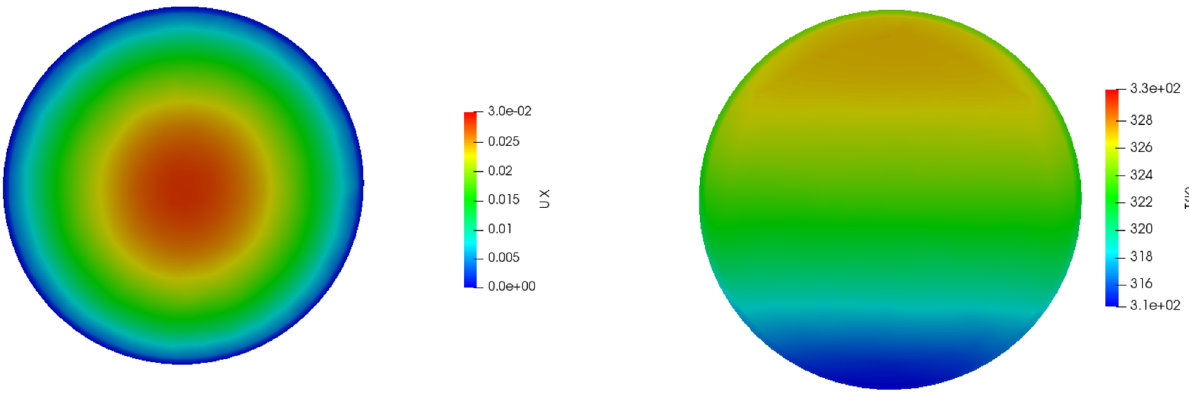
Fig. 13. Velocity (sx) and temperature (dx) profiles at the cooler outlet at t = 1000 s.